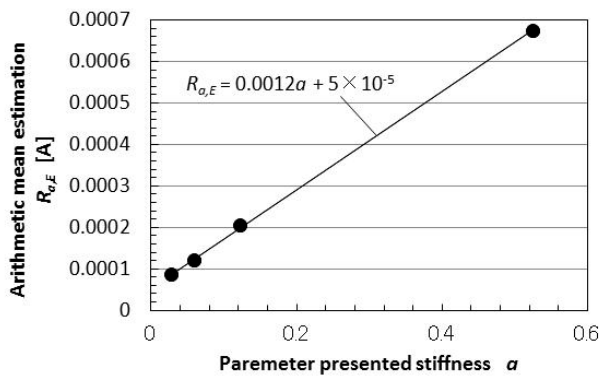
Figure A3. Relation between the parameter estimated of surface roughness of soft body and the softness parameter a [28].